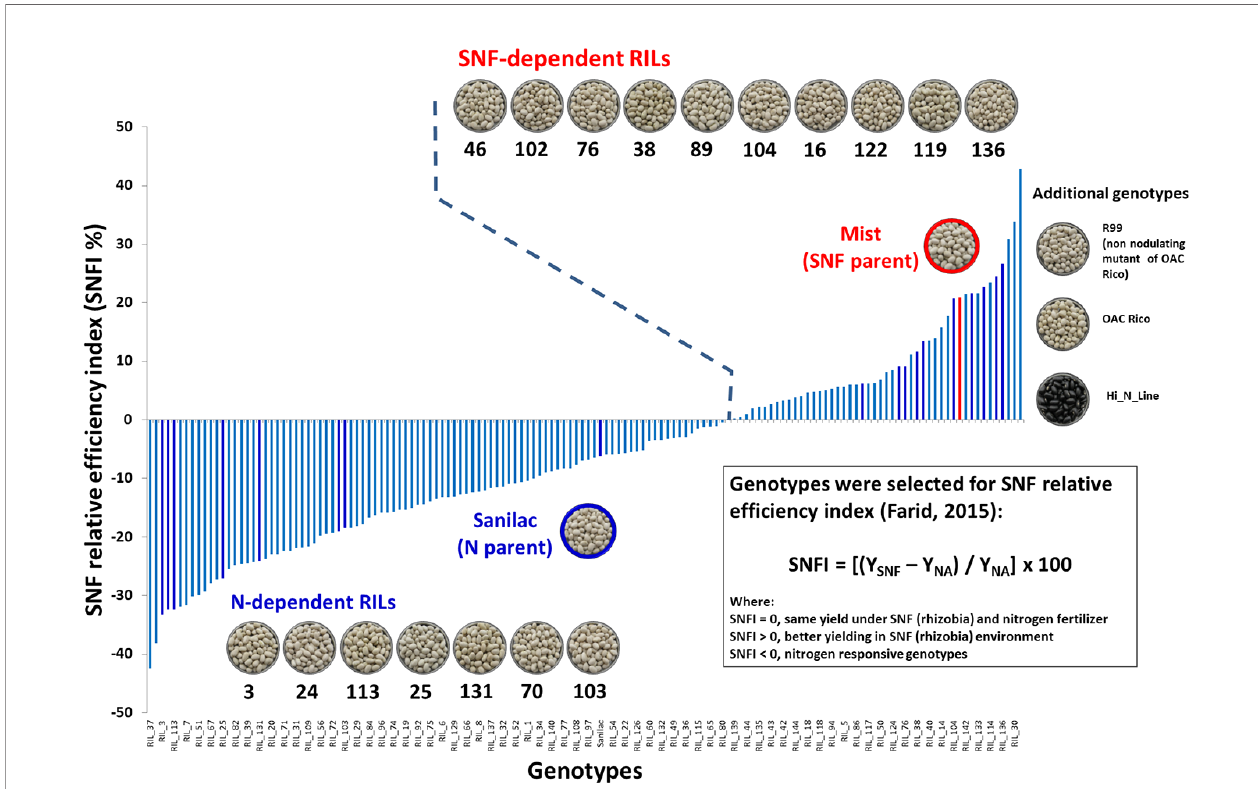
FIGURE 1 | Selection of the common bean genotypes for nitrogen study. Seventeen recombinant inbred lines (RILs) were selected from a Mist x Sanilac mapping population developed at the University of Guelph, ON. The selection was based on the symbiotic nitrogen fi xation ef fi ciency index {SNFI = [(Y SNF – Y NA ) / Y NA ] x 100} and included 10 SNF-dependent RILs (high yield under SNF condition) and seven N-dependent RILs (high yield under nitrogen application). Parental genotypes, Mist (SNF parent) and Sanilac (N parent), were also included. Additional genotypes (right): R99 is a non nodulating mutant of cultivar OAC Rico; OAC Rico (wild type); Hi_N_Line, black genotype selected for high %Ndfa. SNFI-based genotype distribution was modi fi ed with permission (Farid, 2015; PhD thesis, University of